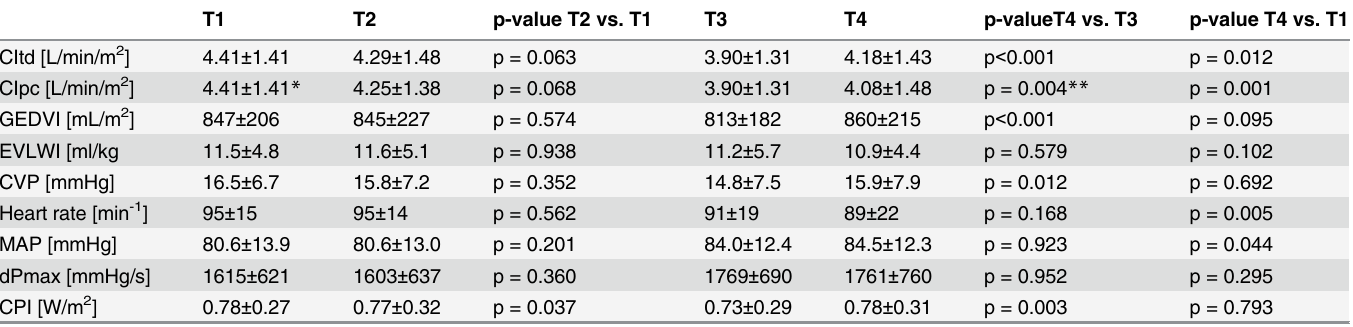
Table 4. Haemodynamic parameters over